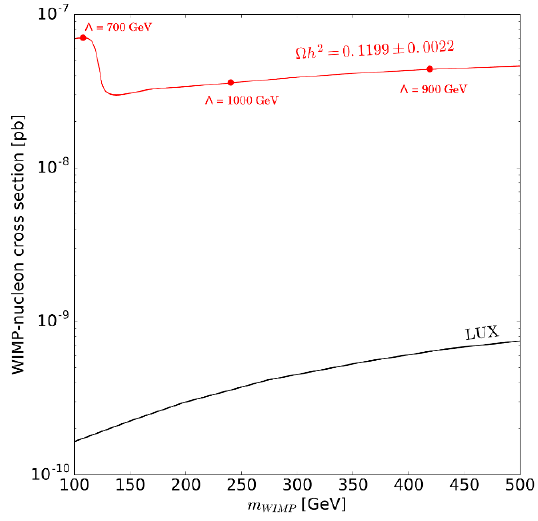
Figure 1 . For the pure singlet case, with a Wilson coe(cid:14)cient (cid:20) normalised to 1 and the scale (cid:3) chosen such as to generate the observed relic density via freeze-out, the corresponding WIMP- nucleon cross section is ruled out by direct detection (we compare the normalised cross-section with the latest LUX limits